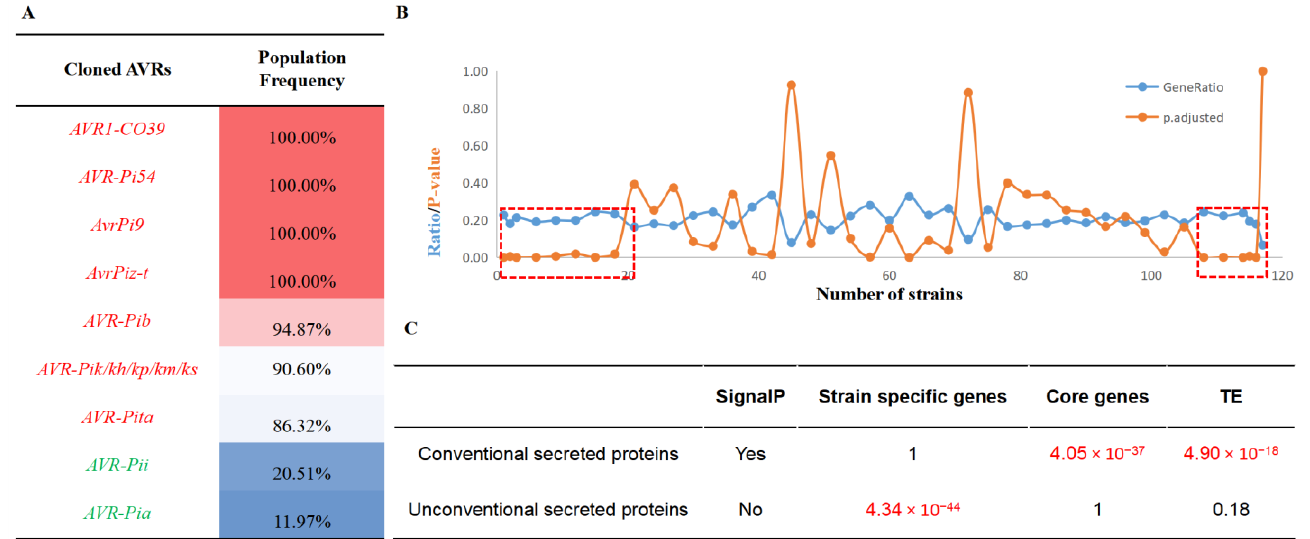
Figure 5. The secreted proteins variation patterns in the pan-genome. ( A ) The population frequency of cloned avirulence genes. ( B ) The population frequency of secreted proteins. It showed that se- creted proteins were significantly enriched in the regions of core genes and specific genes. ( C ) Con- ventional secreted proteins were enriched in core genes and have significant association with TE. Meanwhile, the unconventional secreted proteins were enriched in specific genes and have no sig- nificant association with TE.